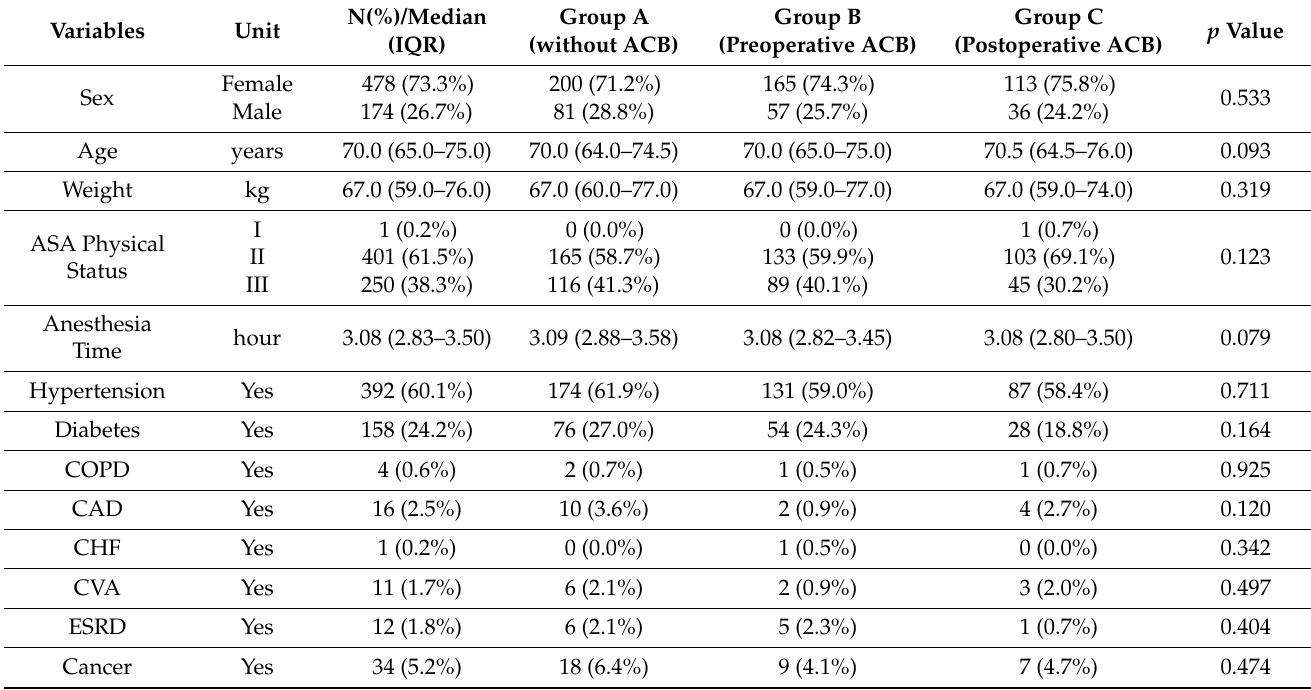
Table 1. Demographic characteristics of patients who underwent primary total knee arthroplasty under bispectral index- guided sevoflurane anesthesia, without adductor canal block (ACB) (Group A), with preoperative ACB (Group B), and with postoperative ACB (Group